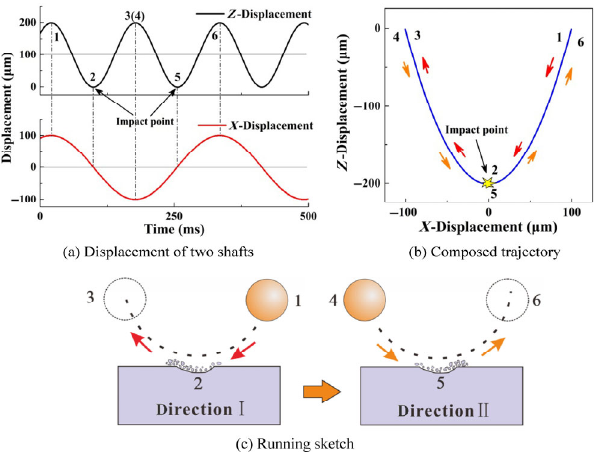
Fig. 4 Theoretical displacement of the two directions and composed trajectory under reciprocating motion.